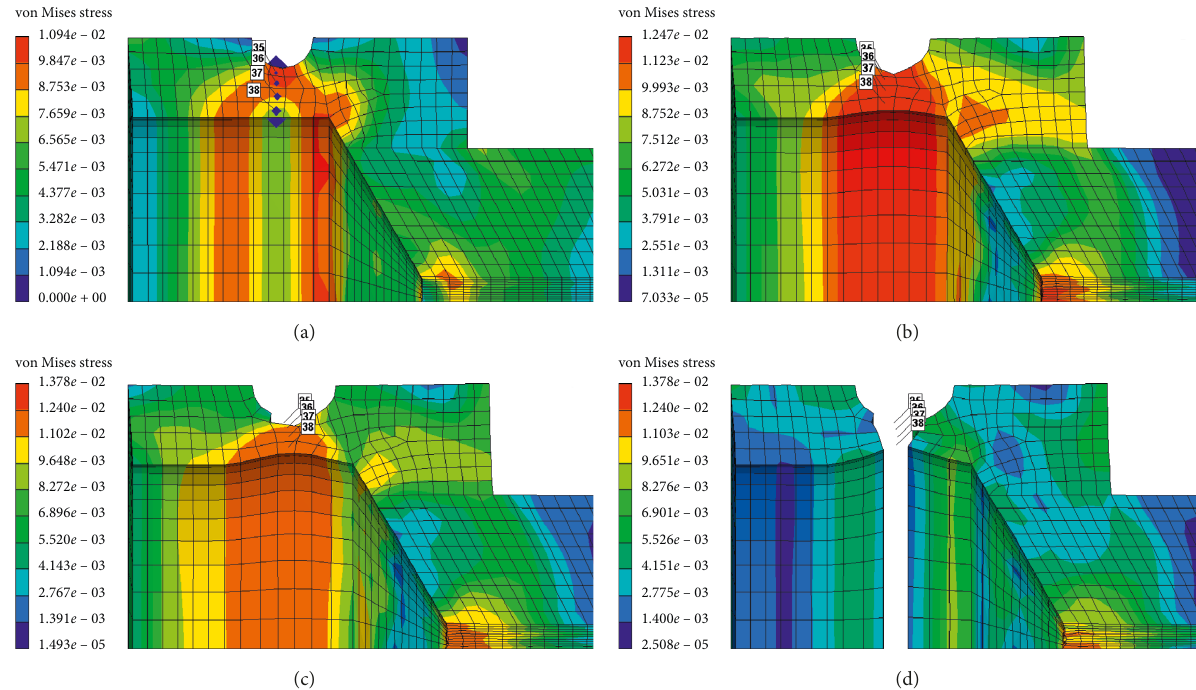
Figure 11: von Mises stress contours on the impair slot. (a) t � 15 μ s, (b) t � 58 μ s, (c) t � 70 μ s, and (d) t � 83 μ